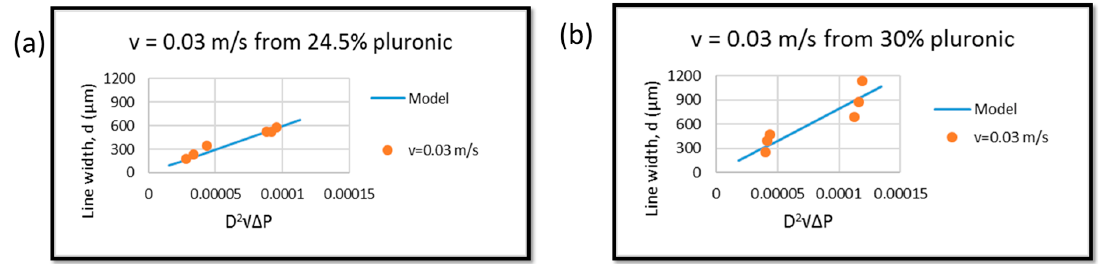
Figure 5. Relationship of d vs. D 2 √ ∆ P of experimental data and theoretical data at different concentrations at v = 0.03 m/s: ( a ) 24 wt % pluronic and ( b ) 30 wt % pluronic.